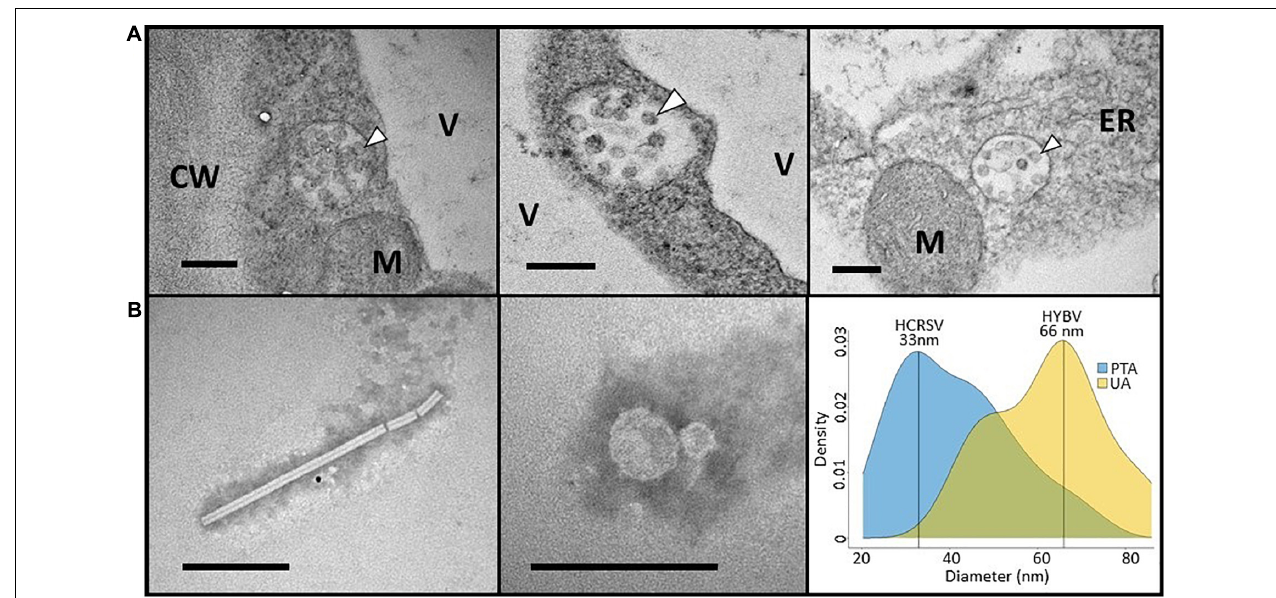
FIGURE 3 | (A) Electron micrographs of hibiscus yellow blotch virus-infected Hibiscus rosa-sinensis leaves containing aggregates of electron dense spherical structures (arrowheads) typically between 50 and 60 nm in diameter. Similar structures were not observed in healthy tissue. CW, cell wall; ER, endoplasmic reticulum; M, mitochondrion; V, vacuole. (B) Electron micrographs of a rod-shaped virion (left) and spherical particles (center) partially purified from H. rosa-sinensis leaves co-infected with hibiscus latent Fort Pierce virus (HLFPV), hibiscus chlorotic ringspot virus (HCRSV), and hibiscus yellow blotch virus (HYBV). The rod-shaped virion is consistent with the HLFPV virion, whereas the spherical particles could represent HCRSV and HYBV virions. A density plot was generated to determine the frequency of spherical particles stained with either phosphotungstic acid (PTA) or uranyl acetate (UA) based on their diameter (right). Particle diameters of 33 and 66 nm were most frequently recorded, which may correspond to HCRSV and HYBV virions, respectively. Bar = 200 nm for all